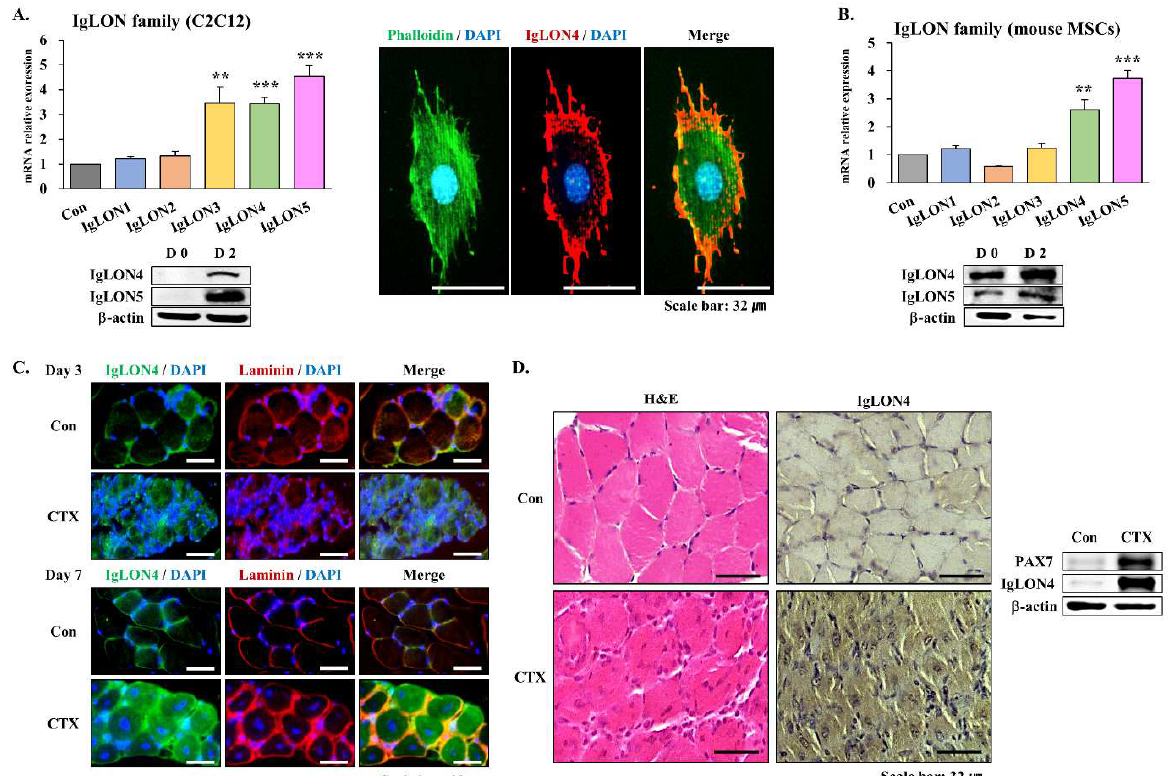
Figure 1. IgLON expressions in murine C2C12 myoblasts and primary MSCs during myogenic differentiation, and IgLON4 protein expression in regenerating mouse muscle: ( A ) mRNA and protein expressions of IgLONs (IgLON1 to 5) in C2C12 myoblasts on differentiation day 2 (DD2) as determined by real-time RT-PCR, and protein expressions of IgLON4 and 5 on DD2 as determined by Western blot. Locations of IgLON4 protein were determined by immunocytochemistry. ( B ) mRNA expressions of IgLONs in mouse primary MSCs on DD2 as determined by real-time RT-PCR, and protein expressions of IgLON4 and 5 as determined by Western blot analysis. ( C ) Expressions of IgLON4 in control and CTX-injected mouse gastrocnemius muscles during regeneration (differentiation days 3 and 7), as determined by immunofluorescence; muscle was collected and embedded with paraffin and then stained with IgLON4 and laminin (Green: IgLON4, Red: Laminin, Blue: Nucleus). ( D ) Expressions of IgLON4 in control and CTX-injected mouse gastrocnemius muscles during regeneration (differentiation day 7), as determined by H&E staining and immunohistochemistry. Protein expressions of PAX7 and IgLON4 were determined by Western blot analysis. Real-time PCR results were normalized to each control (con, before differentiation) and analyzed by t-test. Means ± SD (n ≥ 3). * p < 0.05, ** p < 0.01, *** p < 0.001.